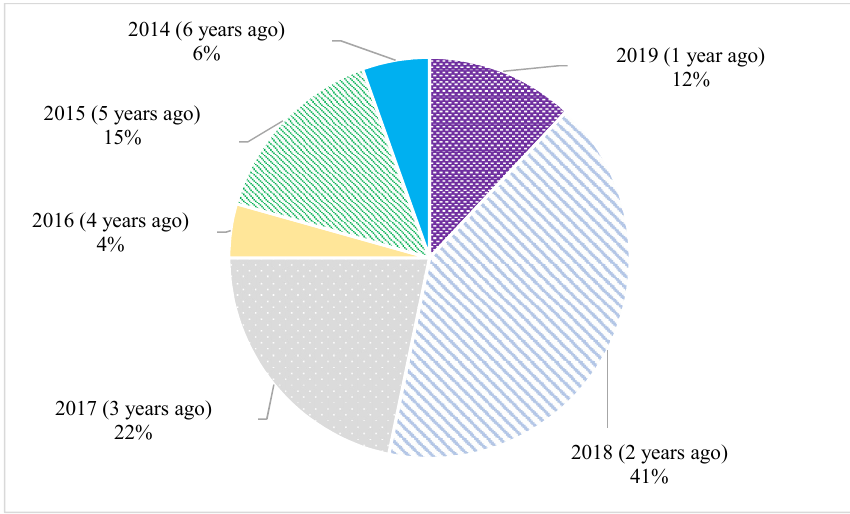
Figure 4. Processors and Retailers: Year They Started Processing or Retailing.